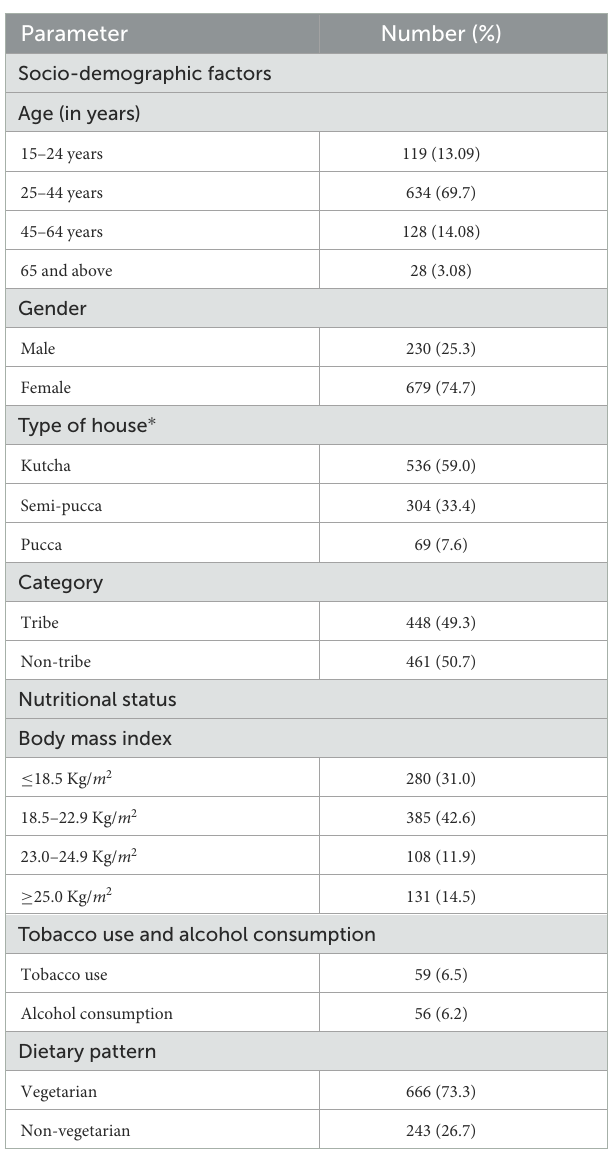
TABLE 1 Distribution of socio-demographic factors, nutritional status, tobacco use, alcohol consumption, and dietary pattern of adults, Tamnar block ( n =